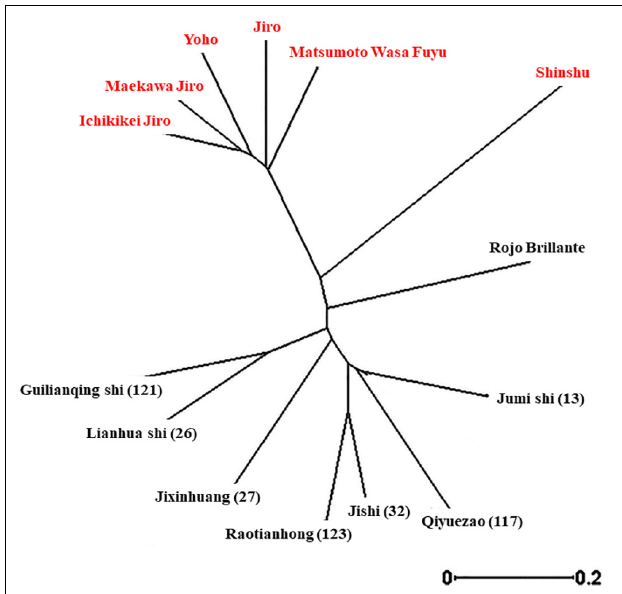
FIGURE 3 | Unrooted neighbor-joining tree of D. kaki cultivars using SSR